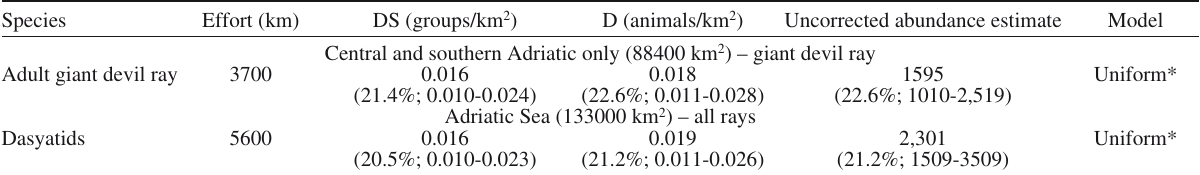
Table 2. – Results of CDS uncorrected abundance estimates for adult giant devil rays and Myliobatiformes in general; DS, group density; D, animal density. CV and 95% CI are given in parenthesis; * strip-transect with right truncation at 225 m. Species